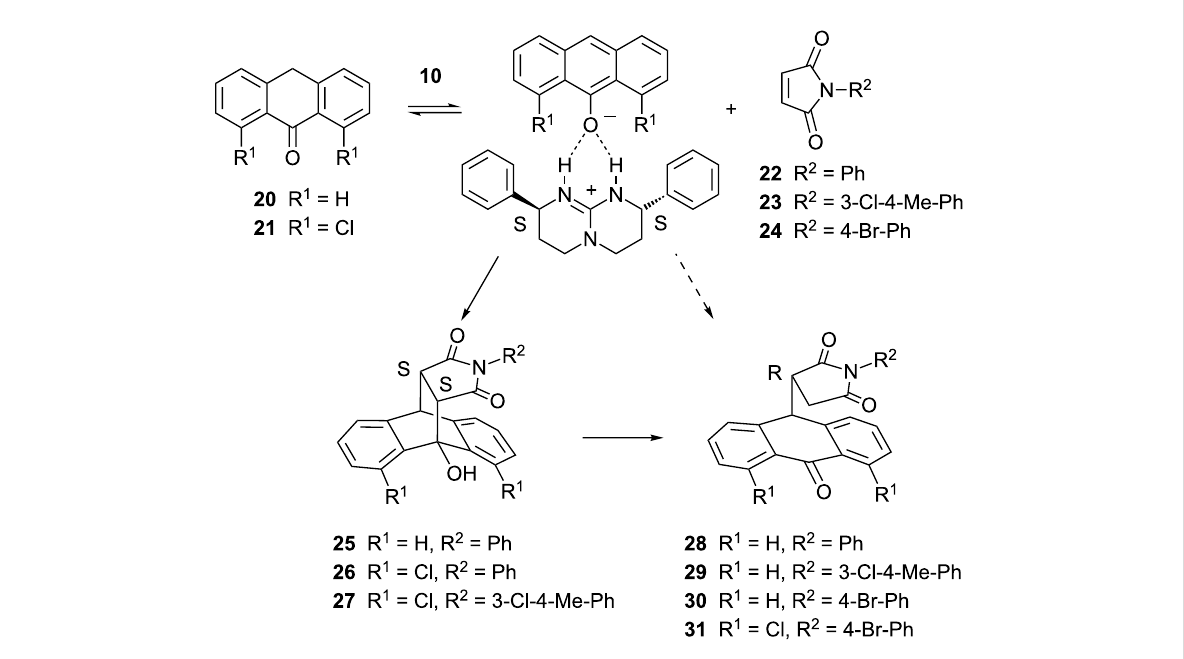
Scheme 2: Reaction of anthrones and N -arylmaleimides catalyzed by guanidine 10 . The guanidine deprotonates anthrones 20 or 21 and forms chiral ion pairs. Primary products of the ion pair complexes are the Diels–Alder adducts that may be further transformed in a base catalyzed retro-aldol reac- tion.